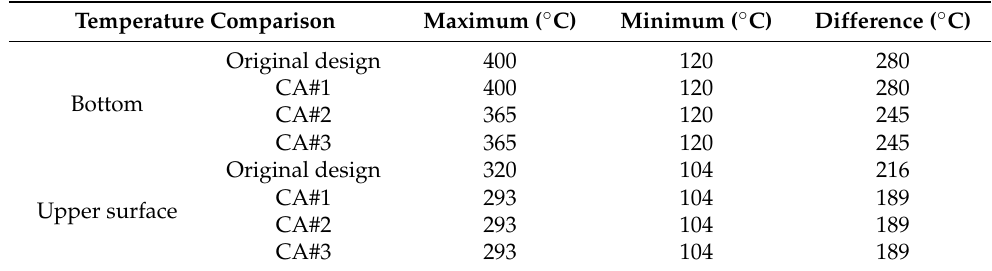
Table 4. Temperature differences of the original and improved stone grill plate designs.